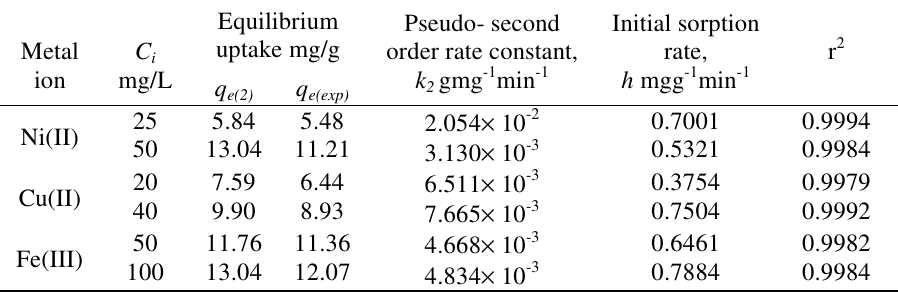
Table 3. Pseudo-second order parameters for CC–metal ion systems